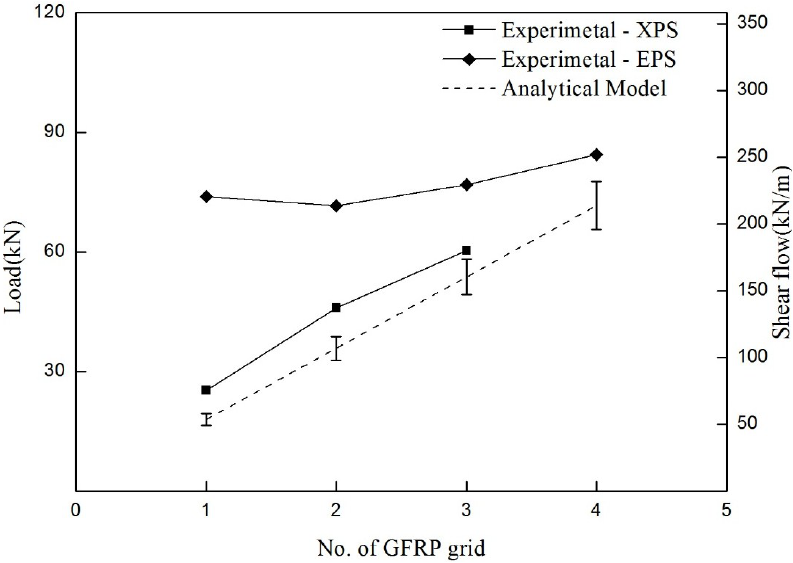
Figure 12. Maximum loads of the experimental test and analytical